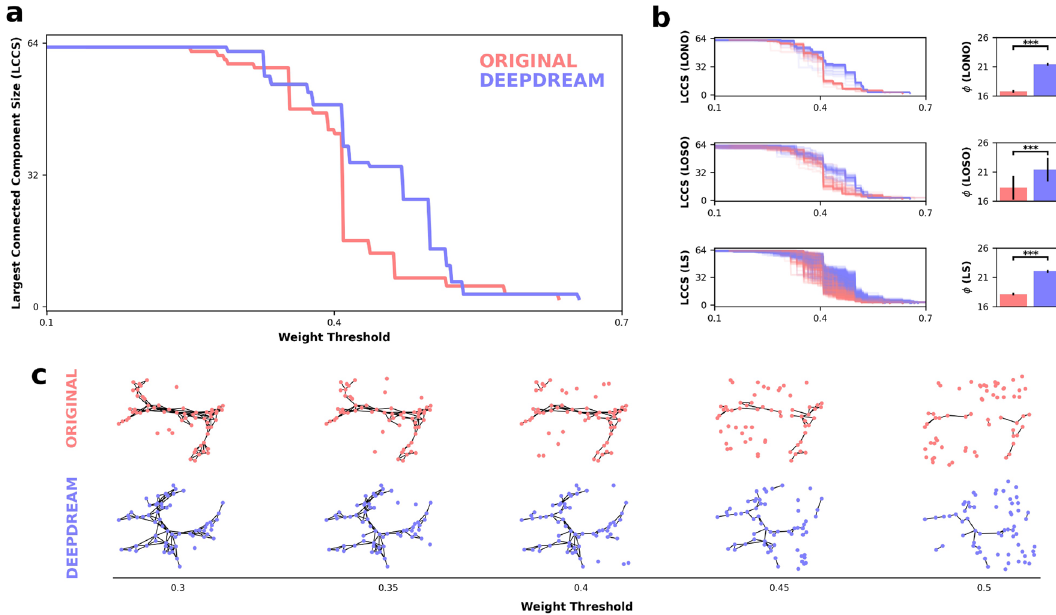
Figure 3. Network percolation and statistical results. ( a ) Line plot representing the percolation process of the OR (red) and DD (blue) full networks. The x-axis represents the weight threshold, starting from the smallest weight in the network (0.1) to a weight strength in which the giant component is smaller than three nodes (0.7). ( b ) On the left, line plots of the LONO, LOSO, and LS procedures. Each line is an iteration, colors encode the conditions. On the right, barplots show the φ between conditions and across the three procedures. Error bars represent the standard error of the mean (SEM). Horizontal black bars represent statistical significance. ( c ) OR and DD semantic networks undergoing the percolation process, visualized at different weight thresholds.